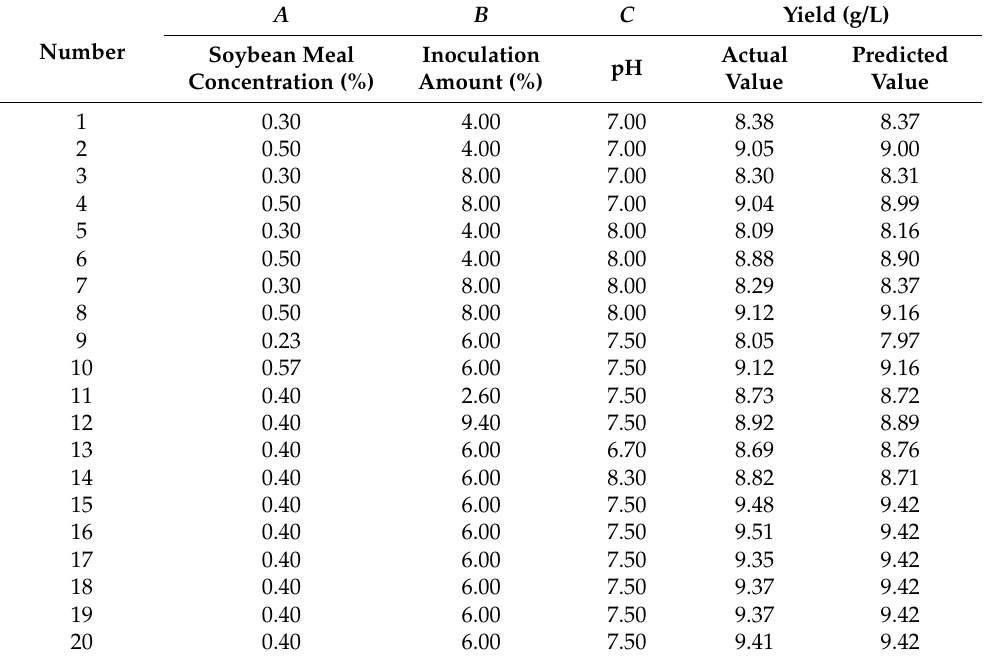
Table 3. Design and results of response surface